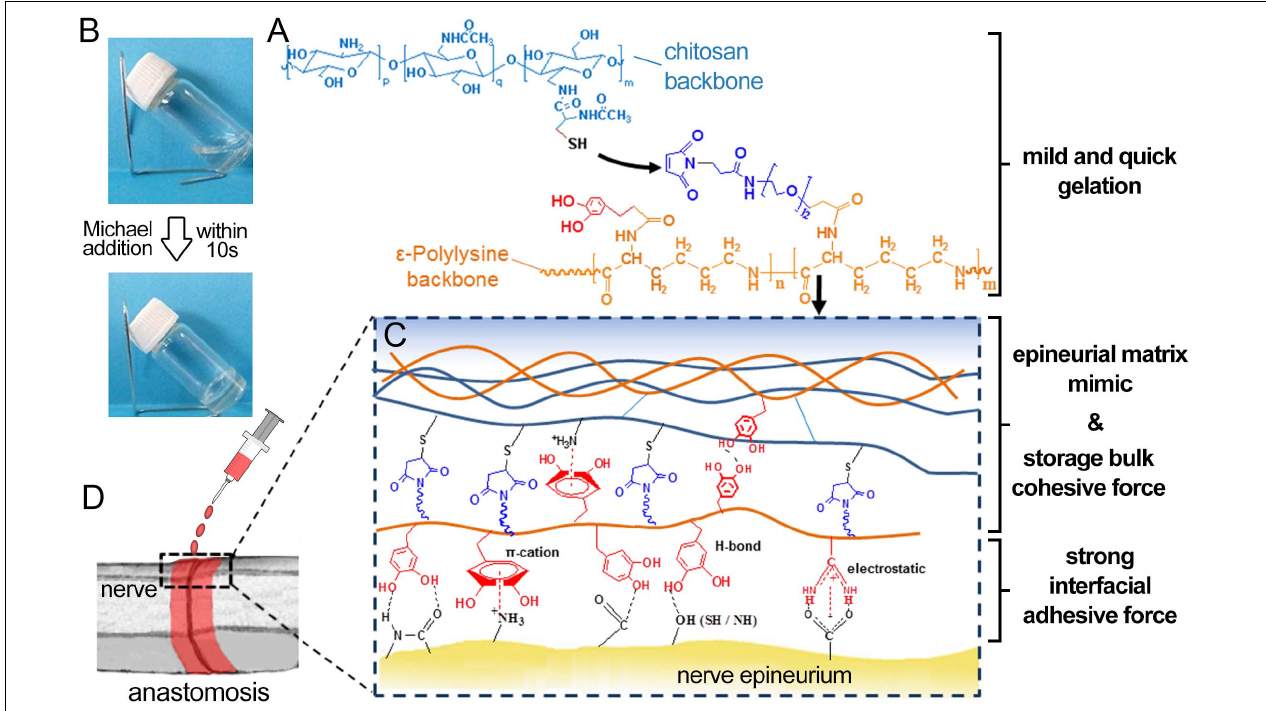
FIGURE 3 | Application of adhesive tissue engineering scaffold (ATES) in nerve repair. (A) Mechanism of Hydrogel Formation. (B) Transforming from prepolymer solution to hydrogel state. (C) Mechanism of adhesion between the hydrogel and the nerve epineurium. (D) Schematic demonstrating the application of ATES in vivo . Reconstructed with permission from Zhou et al.